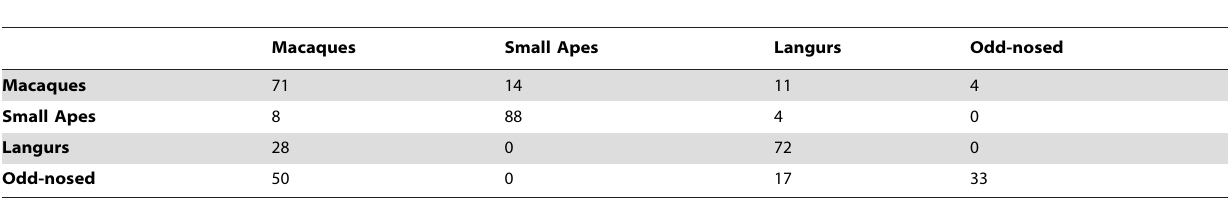
Table 4. Confusion matrix of the LDA showing the posterior misclassifications for each natural clade.